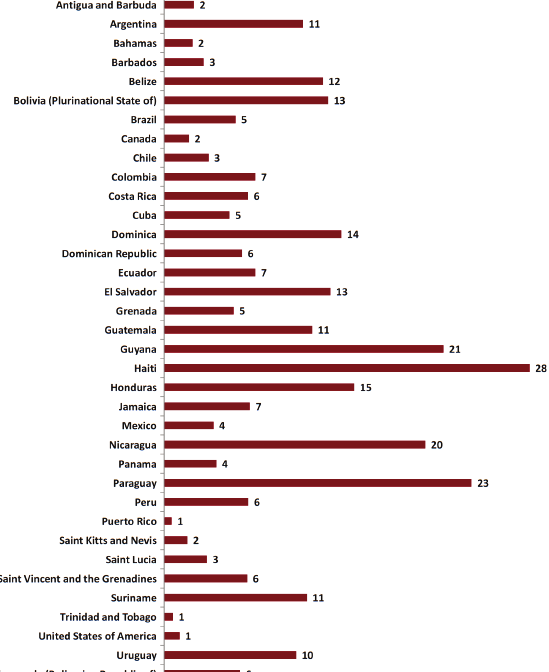
Figure 5: NRI (mm/yr) in 2011, this index is not available for Antigua and Barbuda, Barbados, Dominica, Grenada, Saint Kitts and Nevis, Saint Lucia, and Saint Vincent and the Grenadines (in few cases due to lack of data, value of the index in the previous years has been reported)